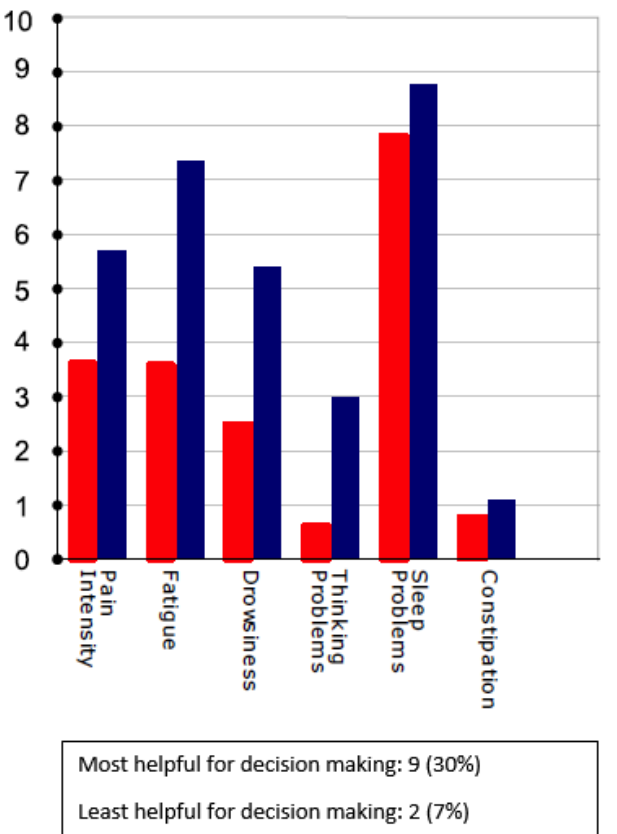
Figure 5. Averaged secondary outcomes (shorter bar is better